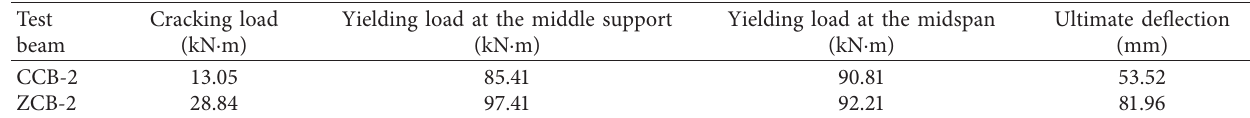
Figure 17: Load-displacement curves of the two-span Table 8: Test results of the two-span continuous composite T-shaped beams.